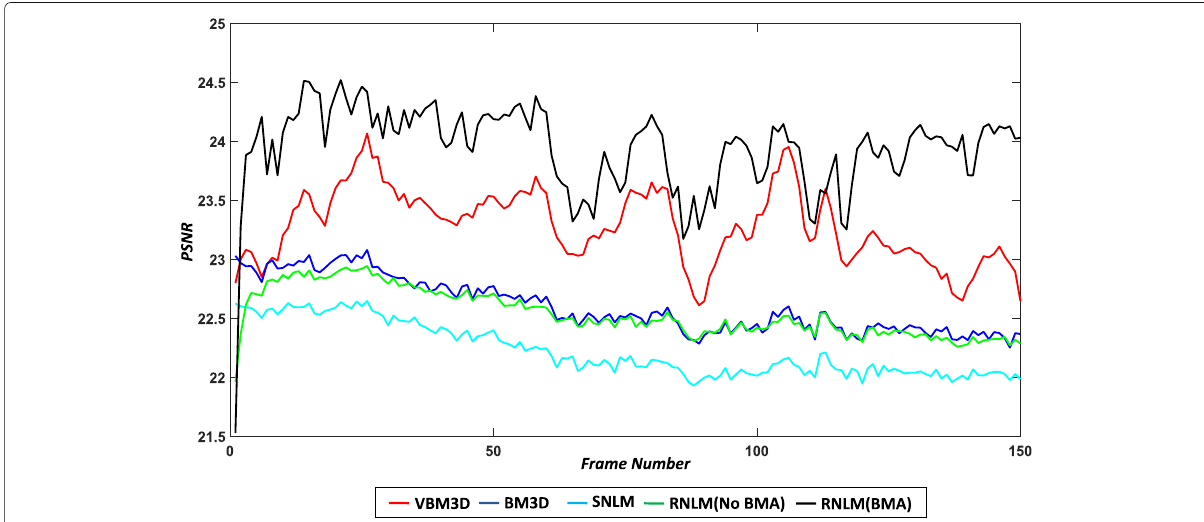
Fig. 2 PSNR (dB) versus frame number using several methods for the Flower Garden sequence corrupted with a noise level of σ = 40. The RNLM (BMA) method gives the best performance for this